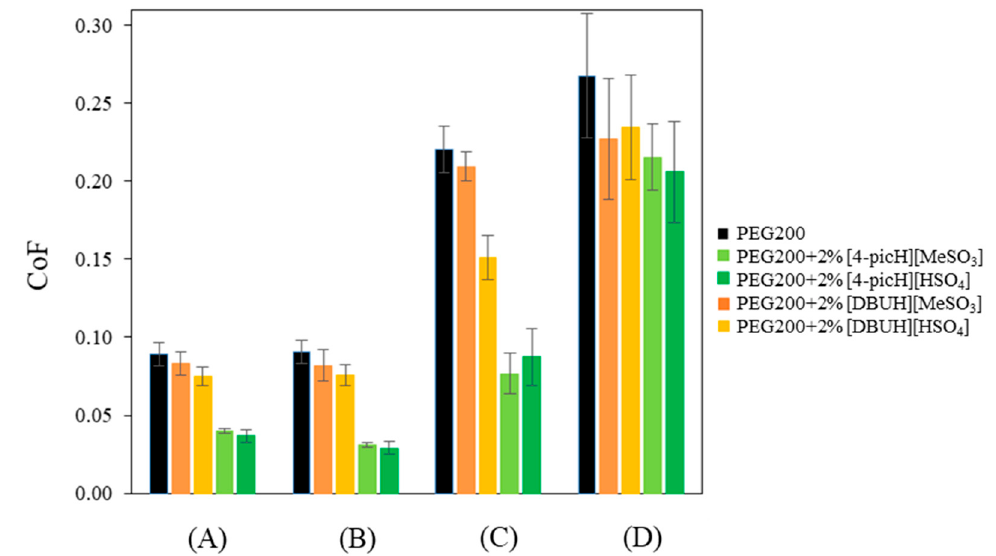
Figure 4. Average CoF values obtained with the pair Si sphere/Si substrate using neat PEG200 and the mixtures PEG200 + 2% PIL as lubricants: short tests under the load of 1 N (A) and long tests under the loads of 1 N (B), 2 N (C) and 4 N (D). The errors are ±standard deviation (n ≥ 3).